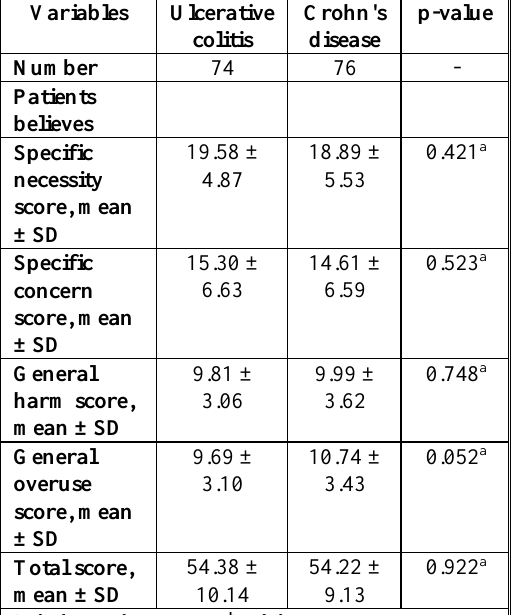
Table 4. Patients believes scores for